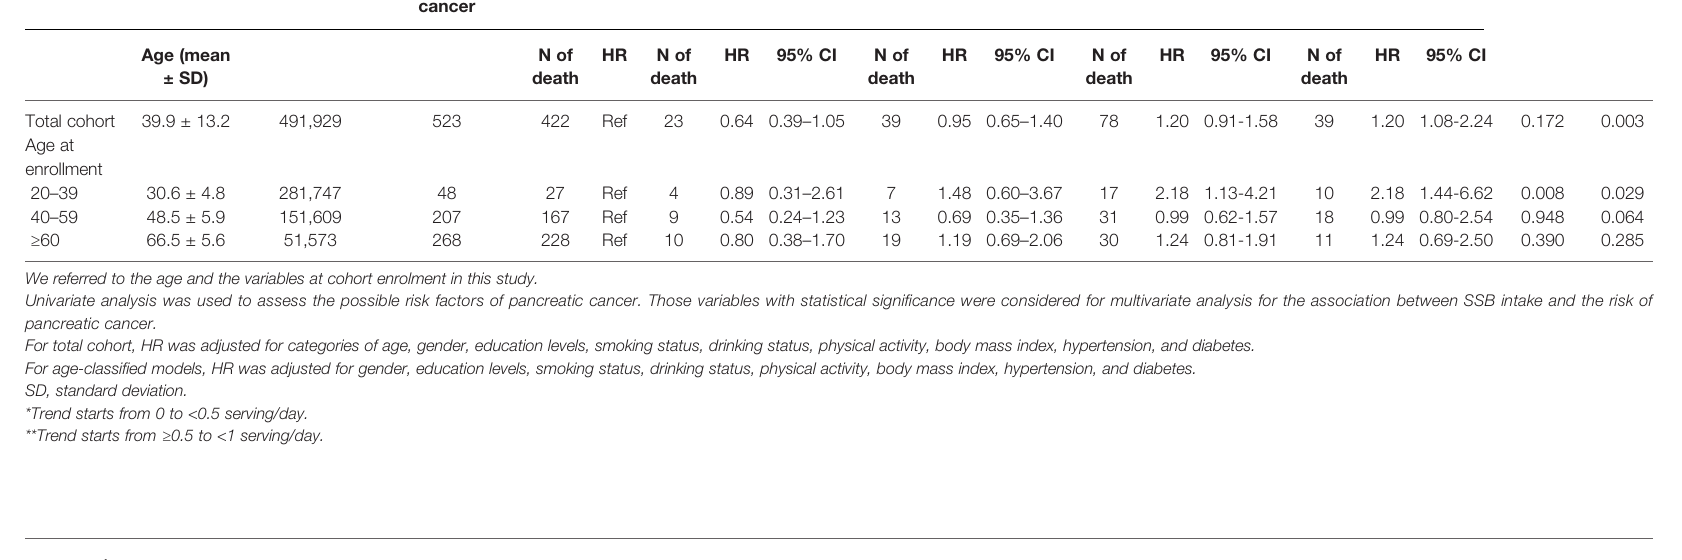
TABLE 4 | Sensitivity analyses for the mortality risks of pancreatic cancer by levels of consumed sugar-sweetened beverages. 0 – <0.5